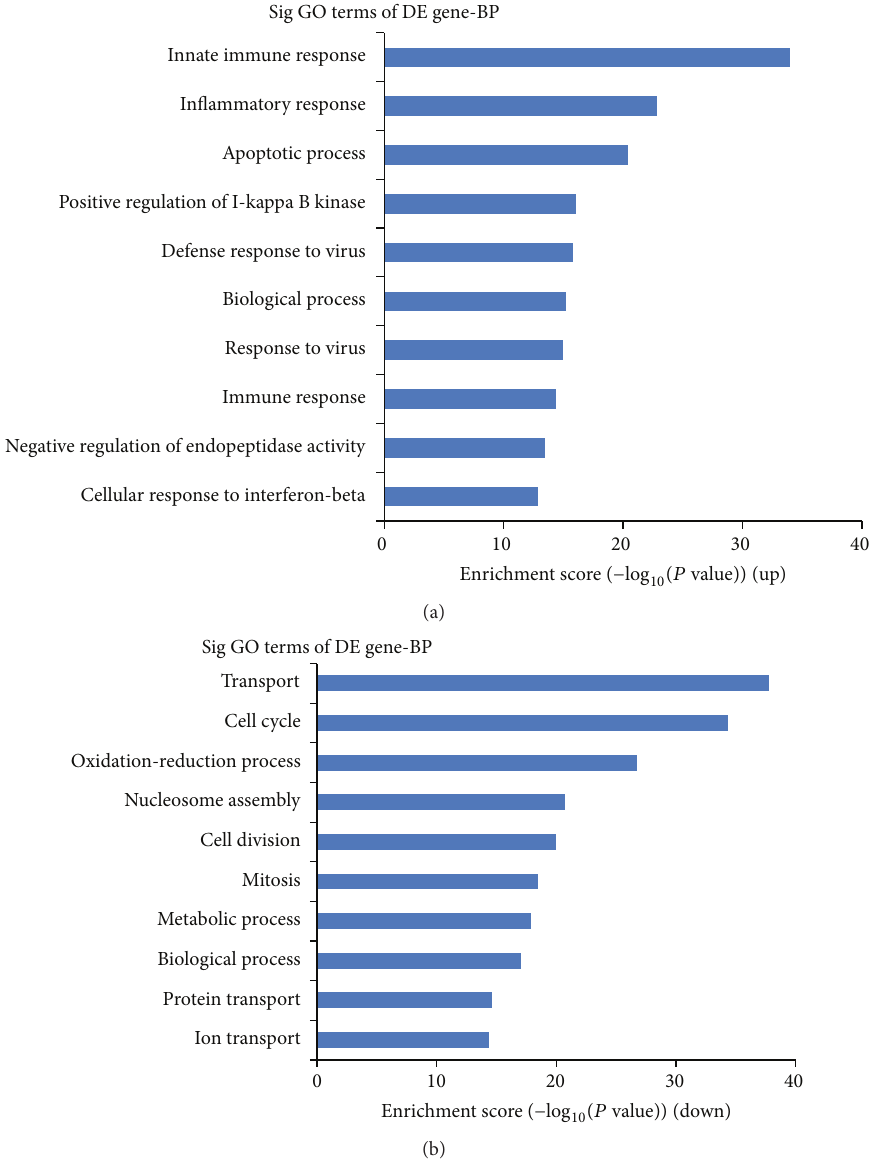
Figure 4: GO analyses. (a) The top 10 GO terms that associated with coding gene function of upregulated lncRNAs are listed. (b) The top 10 GO terms that associated with coding gene function of downregulated lncRNAs are